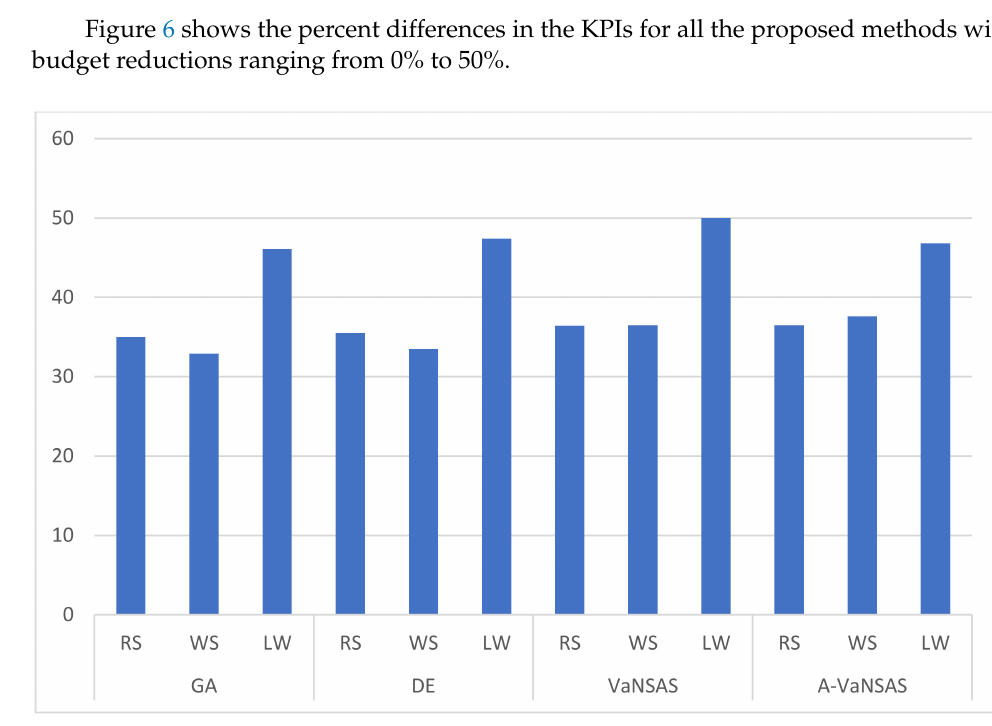
Figure 6. Percent differences in KPIs with budget reductions from 0% to